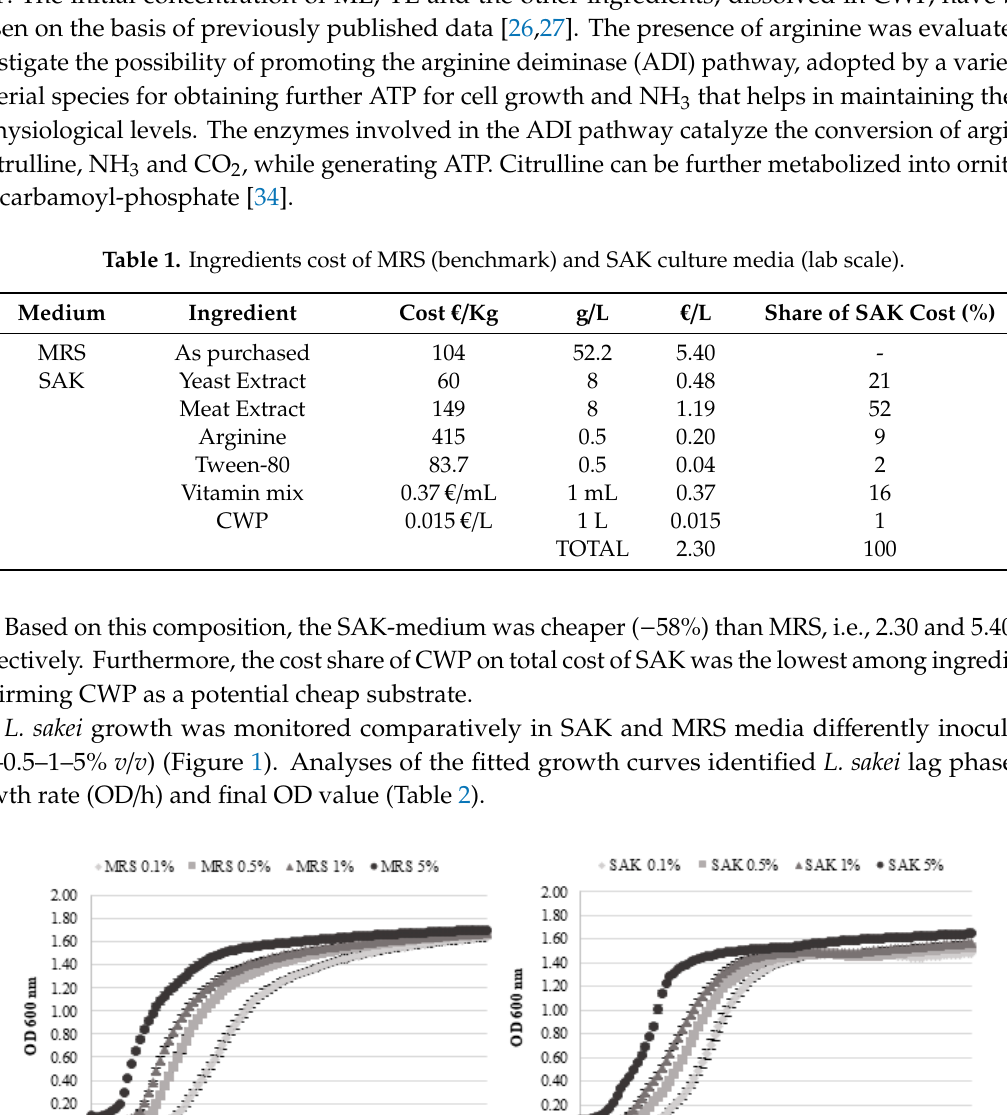
Table 1. Ingredients cost of MRS (benchmark) and SAK culture media (lab scale).